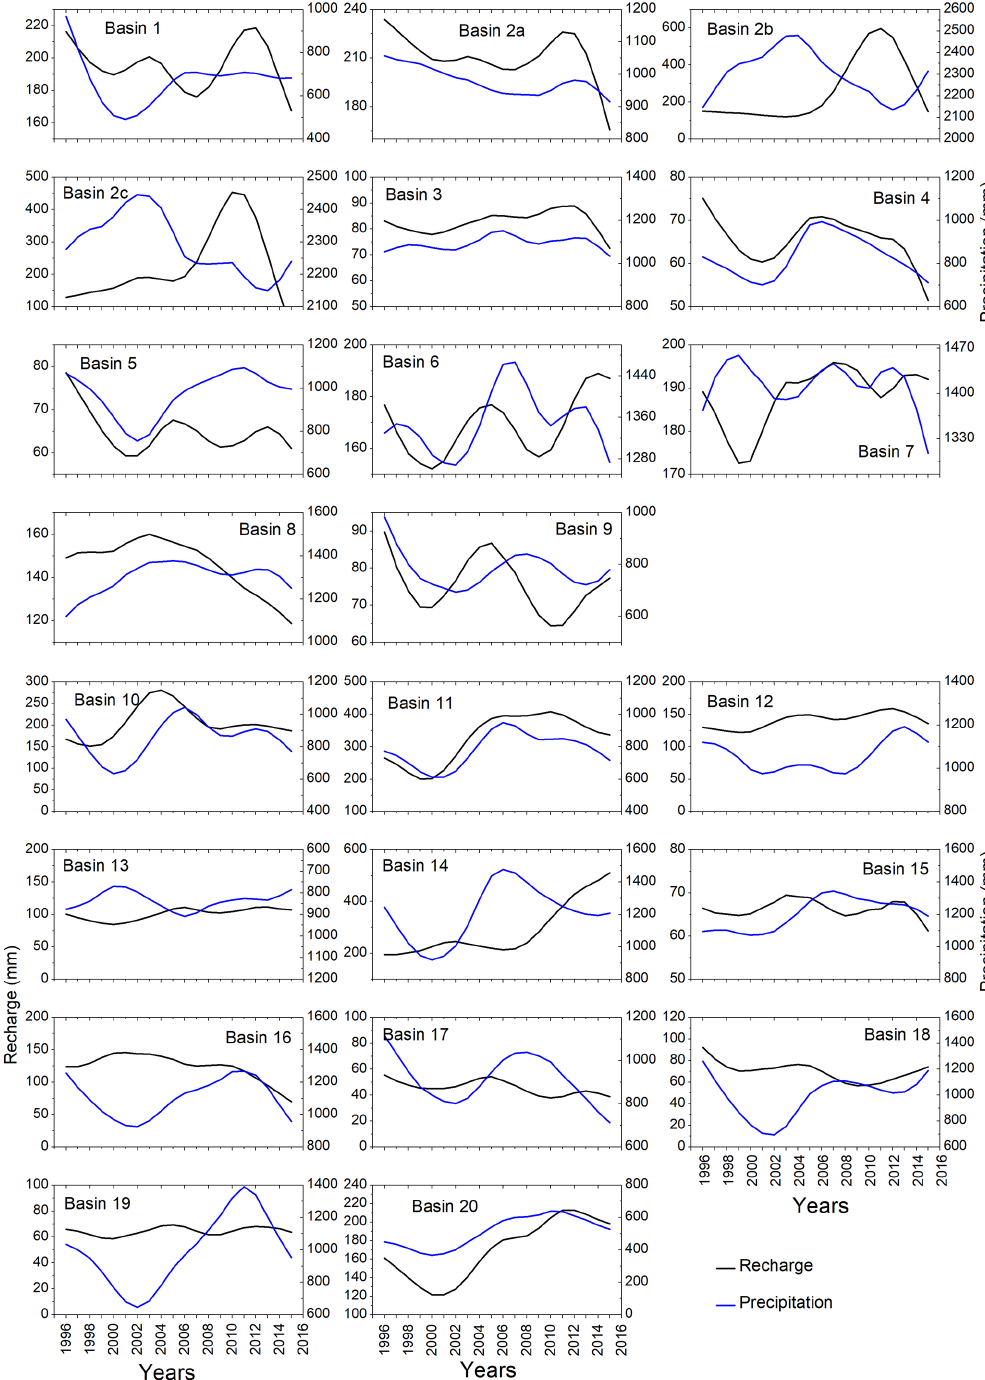
Figure 8. Basin-wide estimates of Hodrick–Prescott trend analysis of R g (mmyr − 1 ) and precipitation (mmyr − 1 ). For basin locations, see Fig. 1.